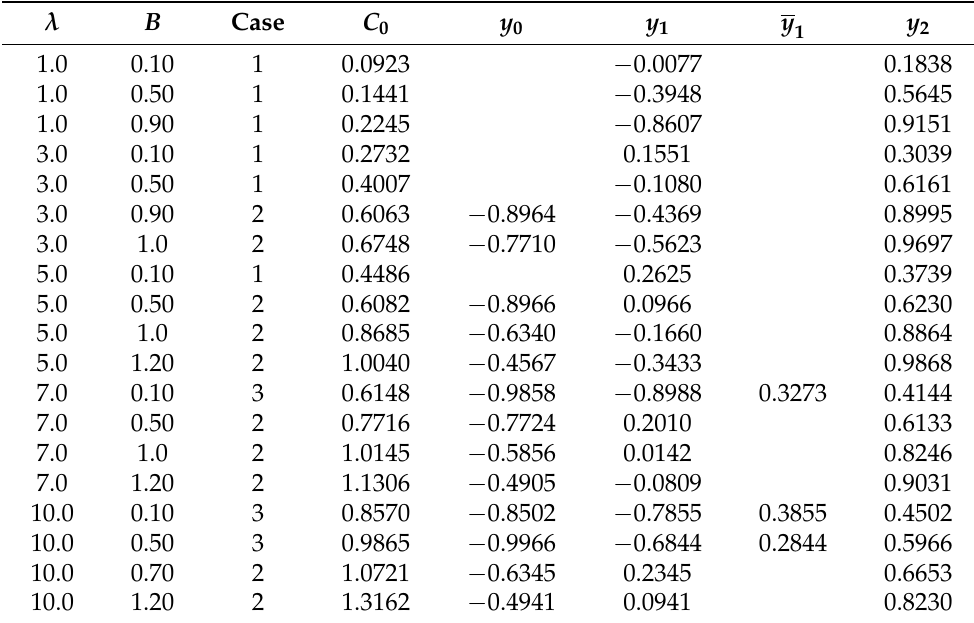
Table 1. Values of C 0 and of the boundaries of the plug regions when λ and B vary.